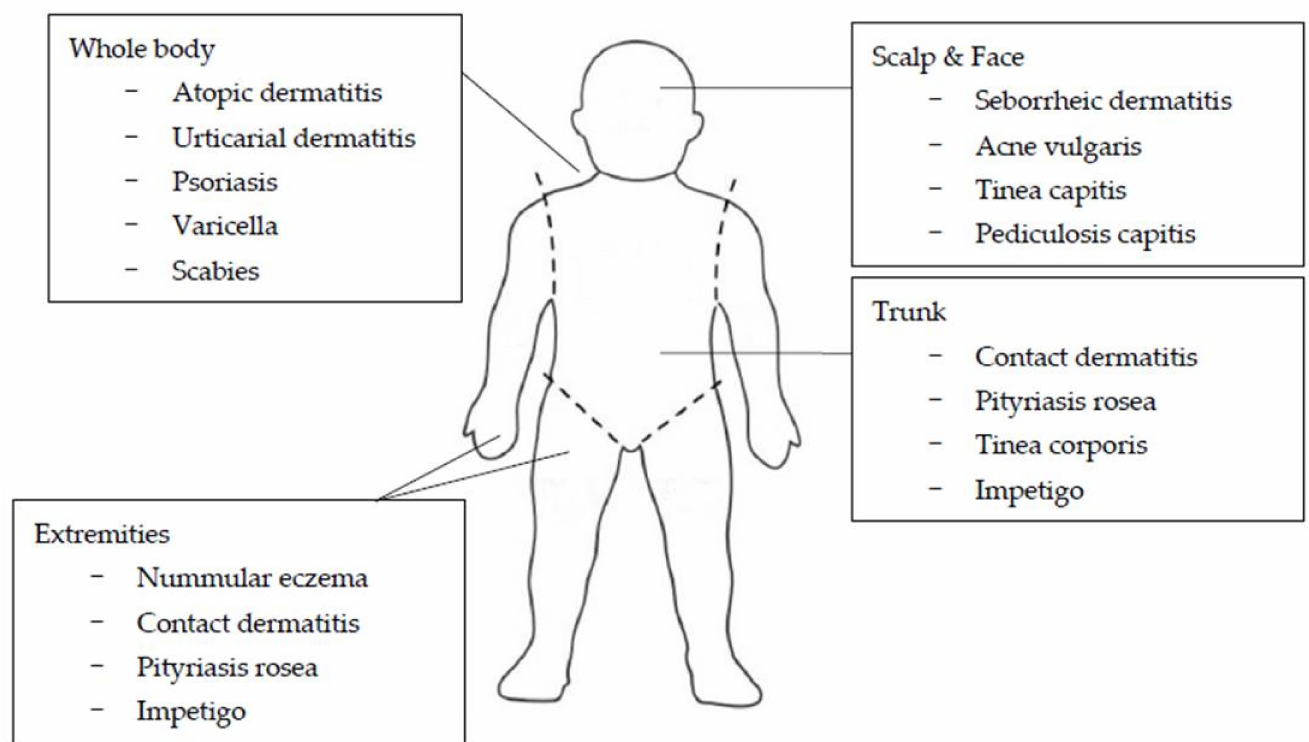
Figure 2. Common areas of skin diseases with itching in children and